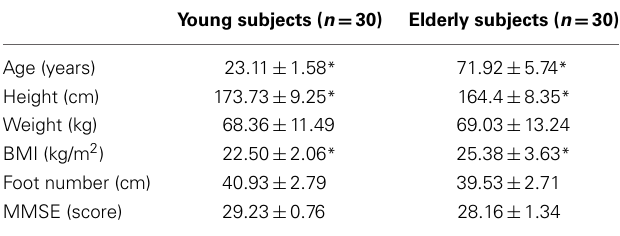
Table 1 | Characteristics of the